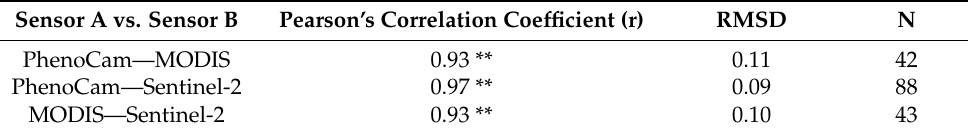
Table 5. Pearson’s correlation coefficient (r) and RMSD between PhenoCam GCC , MODIS GCC and Sentinel-2 GCC . N is sample size.